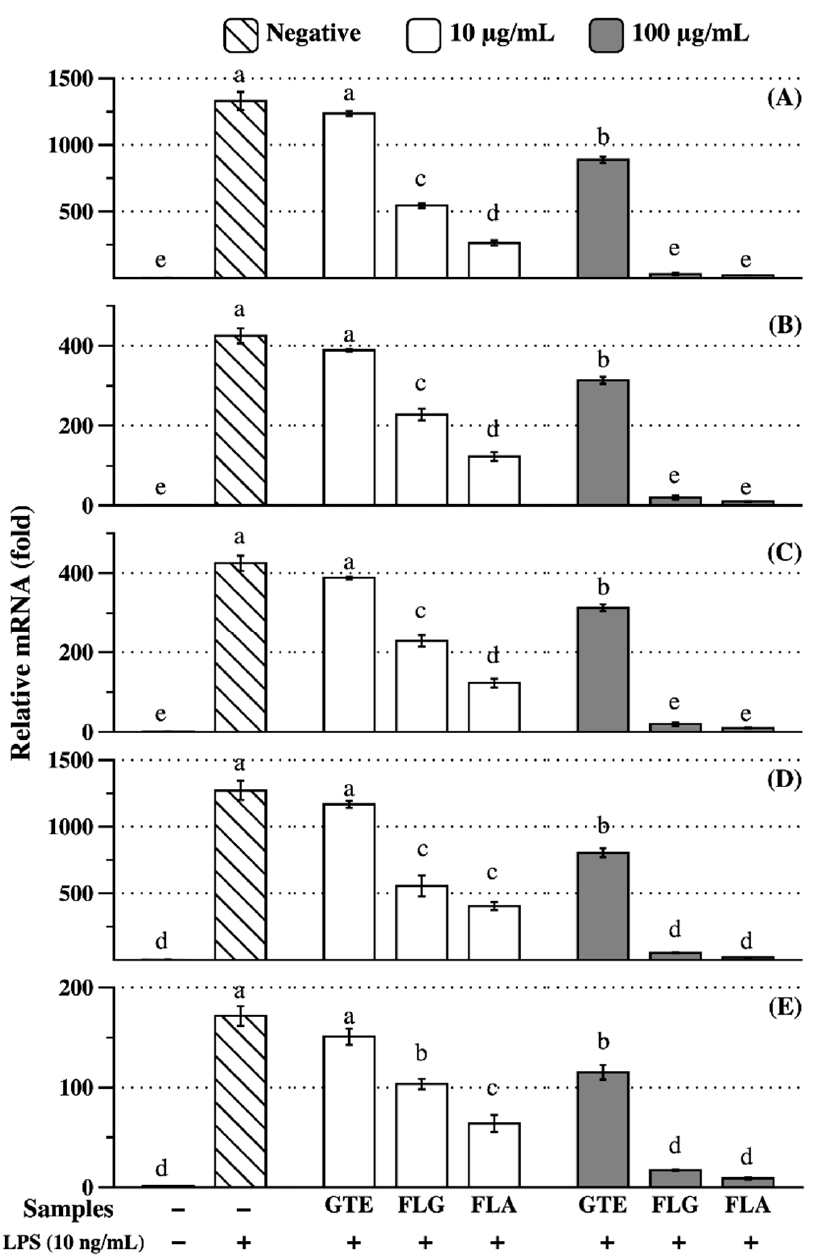
Figure 4. Anti-inflammatory e ff ects of green tea extract (GTE), the fraction rich in flavonol glycosides (FLG), and the fraction rich in flavonol aglycones (FLA) on inflammatory factors, including ( A ) IL-1 β , ( B ) IL-6, ( C ) iNOS, ( D ) COX-2, and ( E ) mmP9 in RAW 264.7 cells. “ + ” indicates that LPS was applied before sample treatment. Lowercase letters on the bars indicate significant di ff erences according to the Tukey–Kramer HSD test ( p <